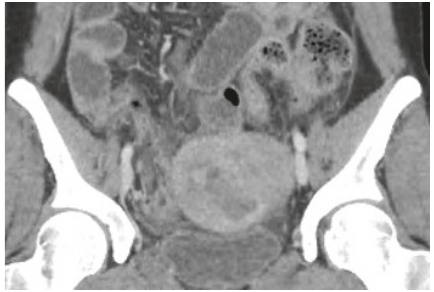
Figure 1: Heterogeneous pelvic mass on CT.